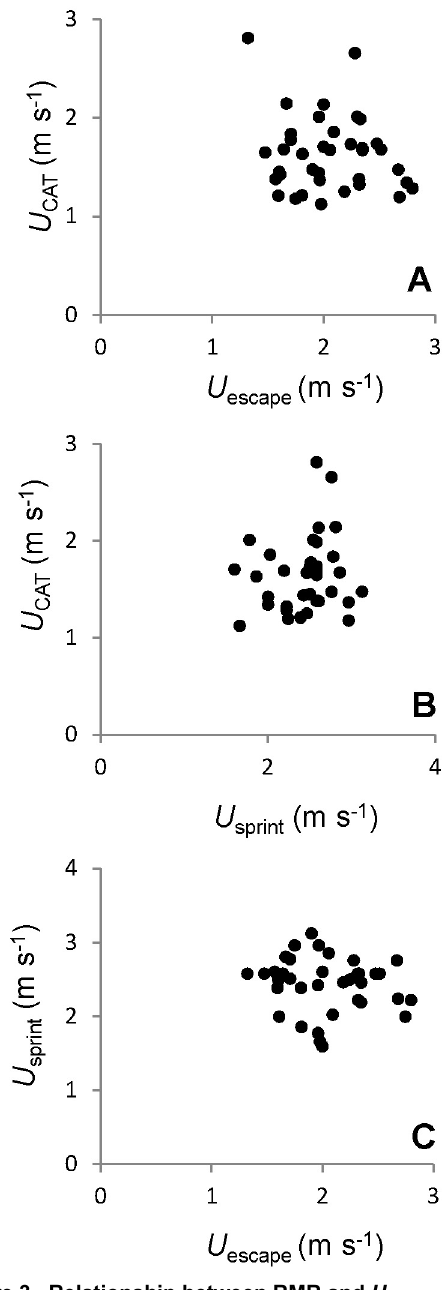
Figure 3. Relationship between RMR and U doi: 10.1371/journal.pone.0072815.g001 (stage 2). The escape response is triggered by the Mauthner cells, a pair of large reticulospinal neurons which receive